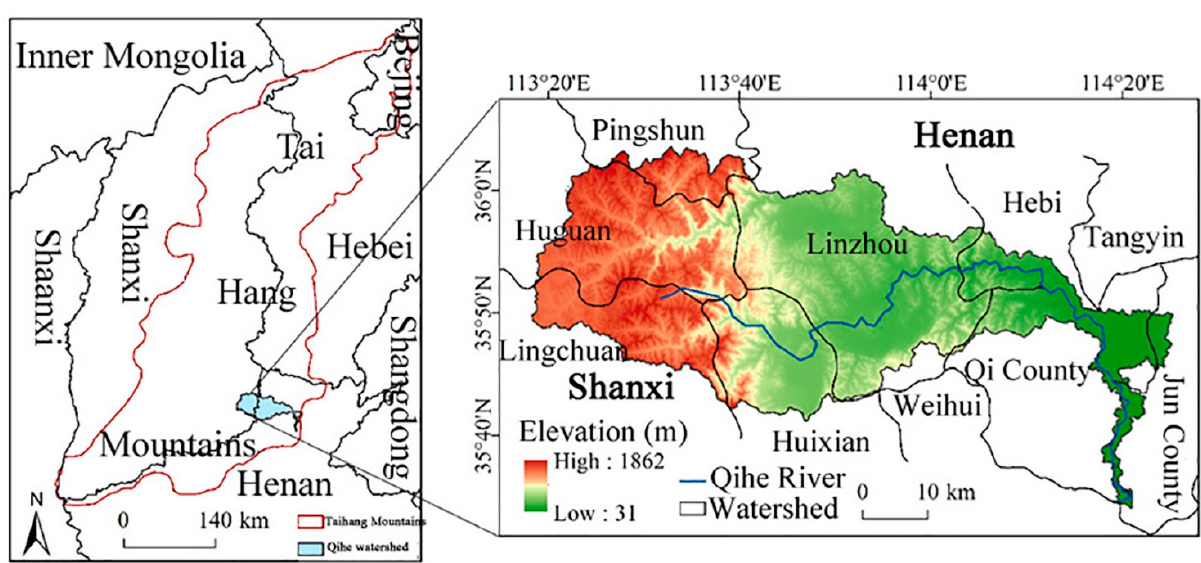
Figure 1. Location and elevation of the study area.